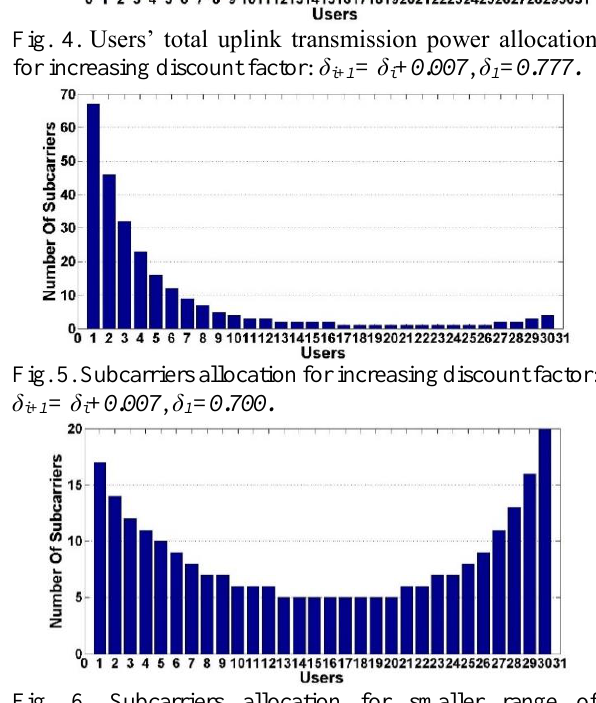
Fig. 6. Subcarriers allocation for smaller range of increasing discount factor: δ i+1 = δ i +0.003 , δ 1